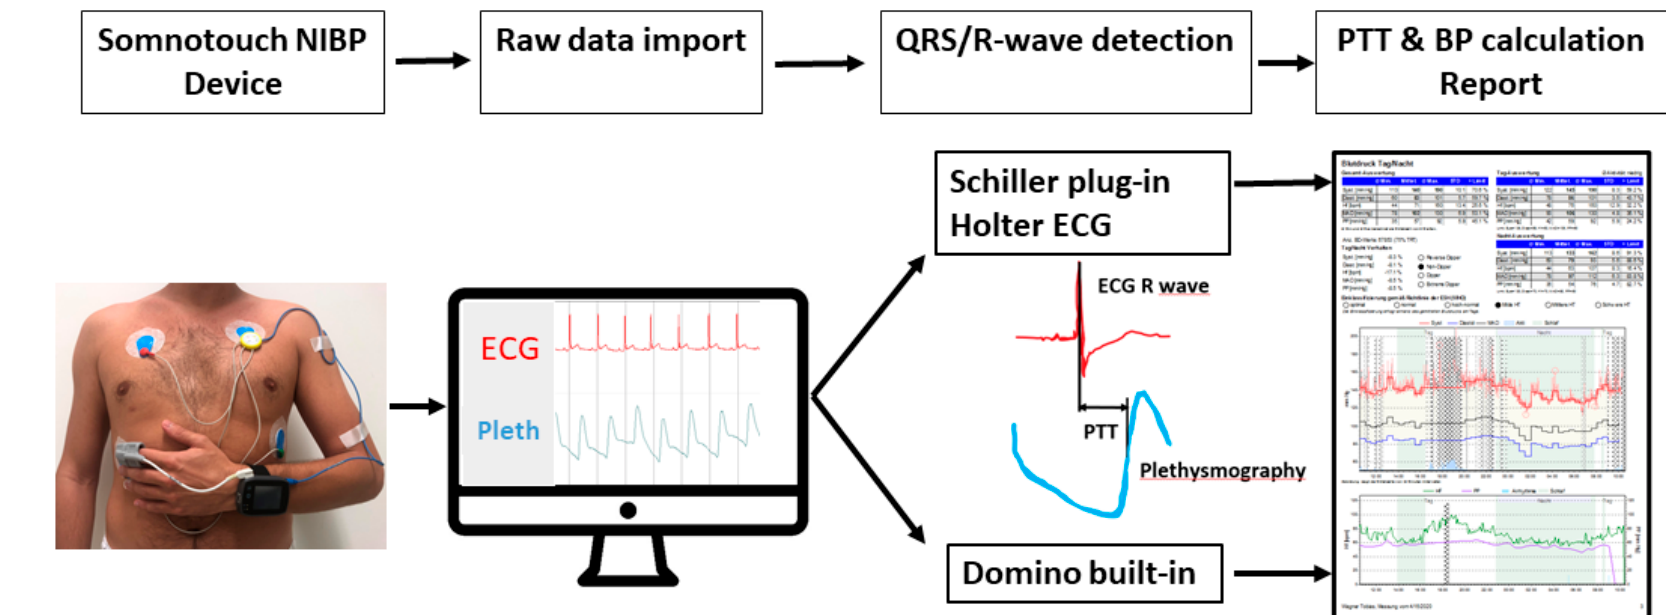
Figure 1. Illustration of the steps which need to be done during the analysis of a Somnotouch-NIBP exam. A patient wearing the device as illustrated. After raw data import, the QRS / R-wave detection is done by the Domino light software, or in the case of Holter ECG analysis by the Schiller plug-in software. From the ECG, QRS / R-waves are detected and used to calculate the pulse transit time. Finally, BP values are calculated according to specific algorithms. BP values are processed and displayed in the form of a diagnostic report. NIBP indicates non-invasive blood pressure; PTT: pulse transit time; BP: blood pressure; ECG: electrocardiography; Pleth: plethysmography.